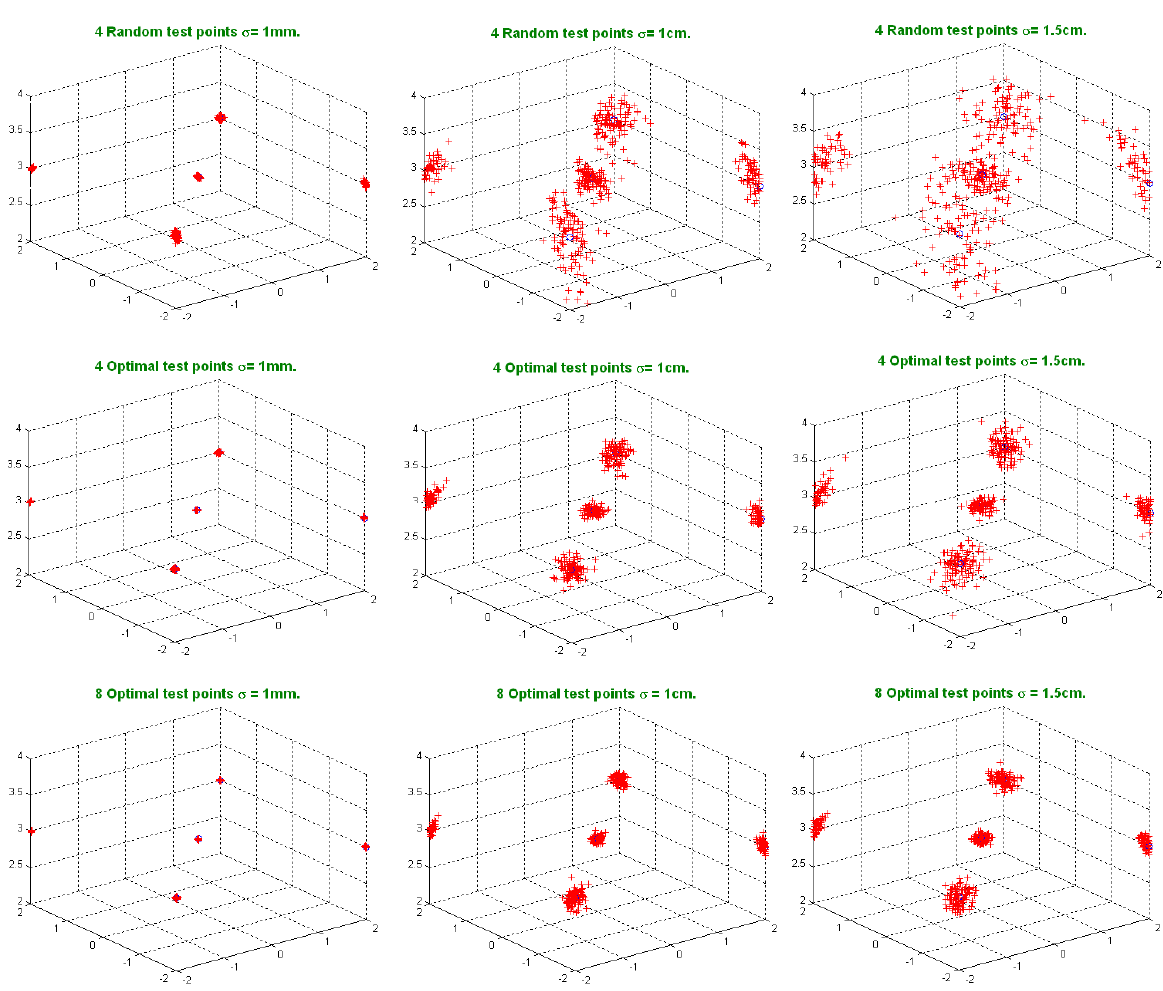
Figure 5. Representation of 100 auto-calibrations for different noise levels in measurements (cid:2026) (cid:3404) (cid:4670)1 mm, 1 cm, 4 cm(cid:4671) , using four random unknown test points; four optimal unknown test points and eight optimal unknown test points (hyperbolic case).